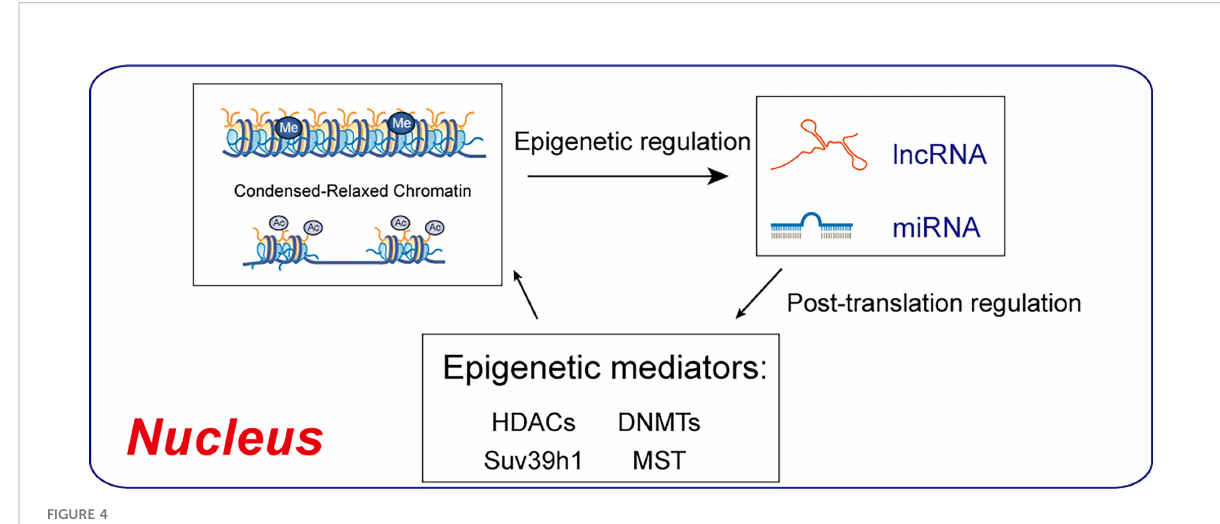
FIGURE 4 Regulatory interactions between epigenetic machinery and non-coding RNAs. DNMTs and HDACs are epigenetic mediators of DNA methylation and histone acetylation, which result in condensed-relaxed chromatin. lncRNAs and miRNAs modulate epigenetic mediators, thus regulating chromatin remodeling.